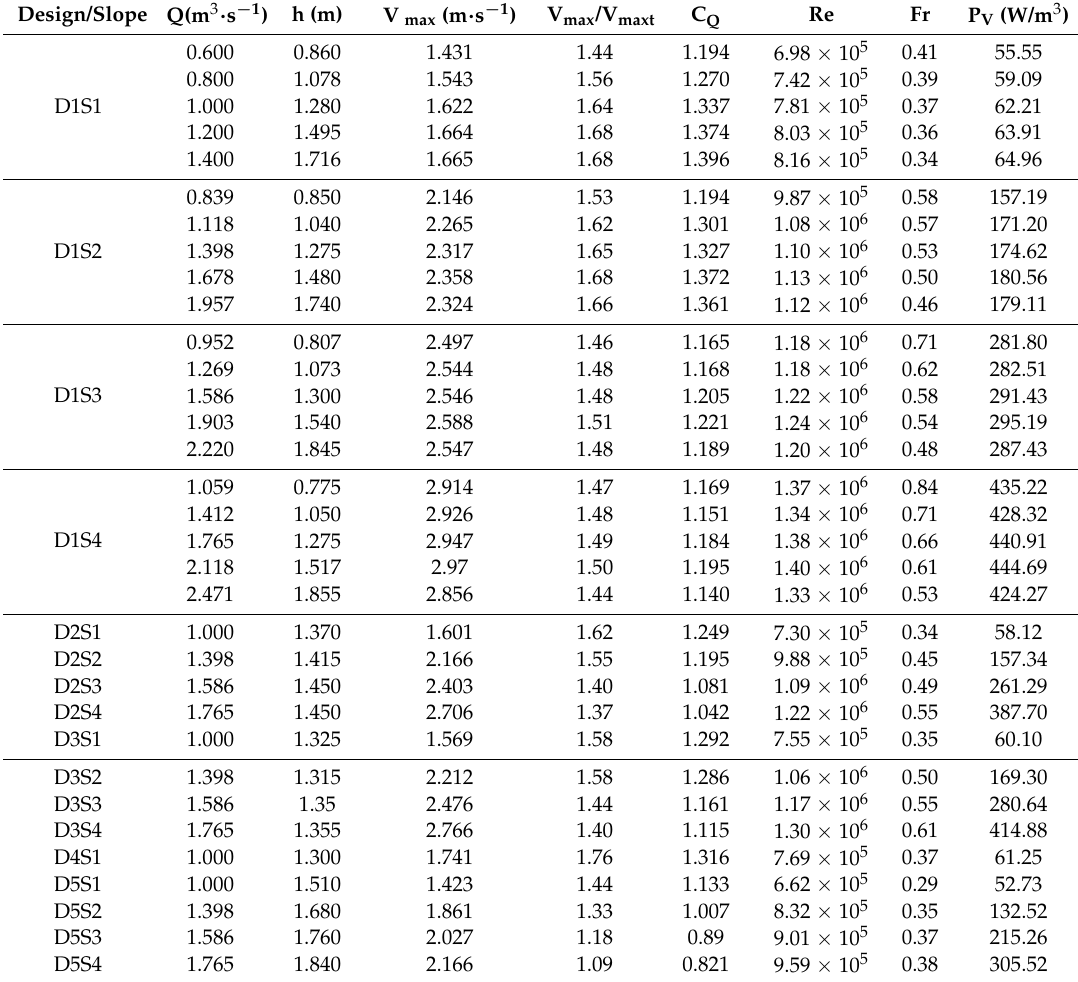
Table 2. Main hydraulic characteristics obtained in all